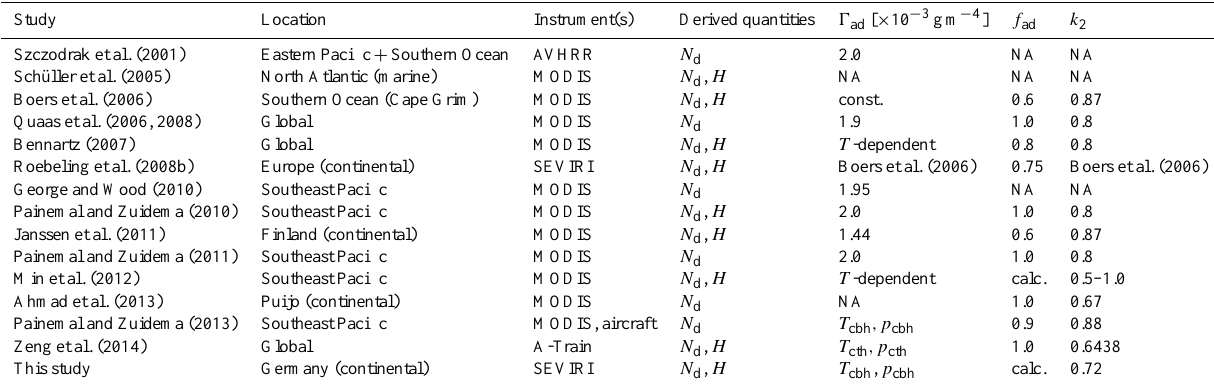
Table 1. Overview of assumptions made for the sub-adiabatic cloud model applied to derive N d and H in literature studies. The table lists the values chosen for (cid:48) ad , f ad (calc. refers to explicitly calculated values from additional data) and k 2 . The table is sorted by publication year starting with the oldest